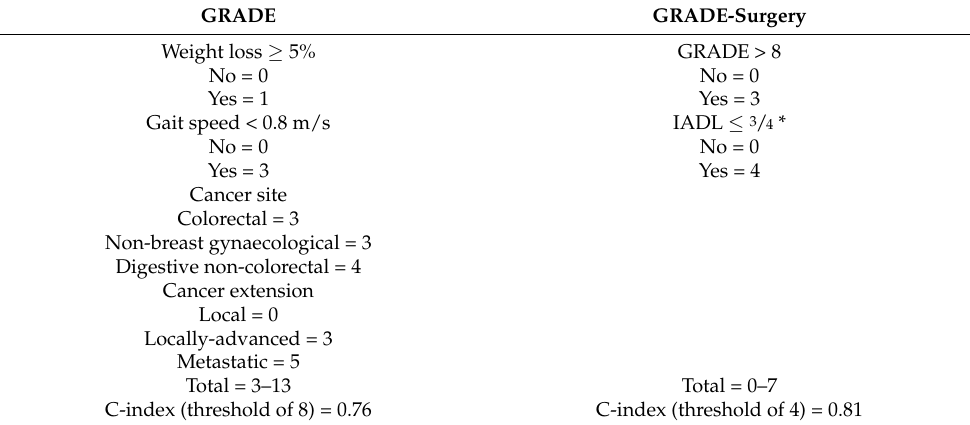
Table A1. The GRADE and the GRADE-surgery scoring systems.